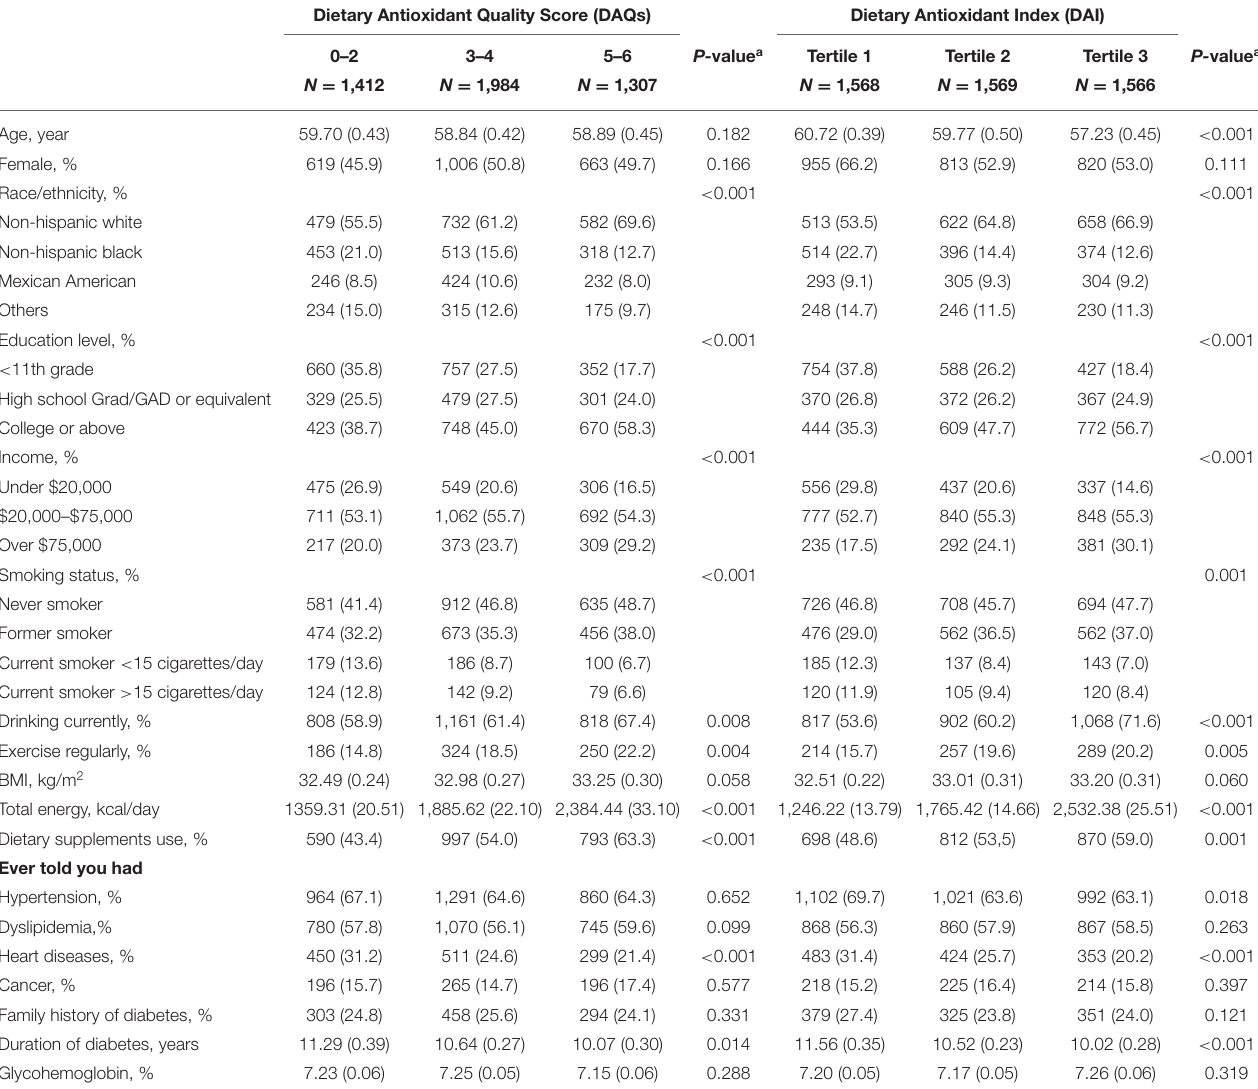
TABLE 1 | Baseline characteristics by the Dietary Antioxidant Quality Score (DAQS) and the Dietary Antioxidant Index (DAI) among adults with diabetes in the National Health and Nutrition Examination Survey (2003–2014). Dietary Antioxidant Quality Score